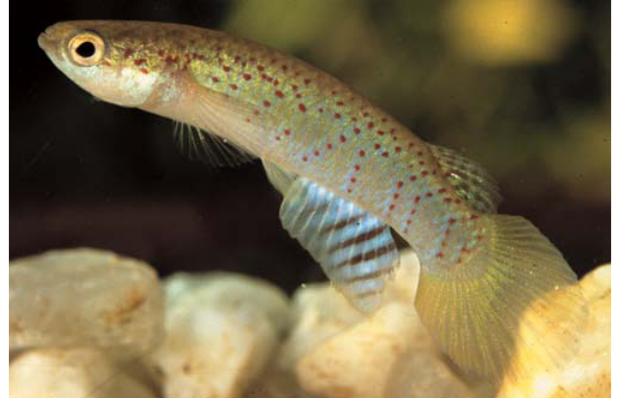
Fig. 3. Rivulus cyanopterus , UFRJ 5911, male, holotype, 27.6 mm SL (one day after collection); Brazil: Mato Grosso: Jaciara. Photo by W. J. E. M. Costa.